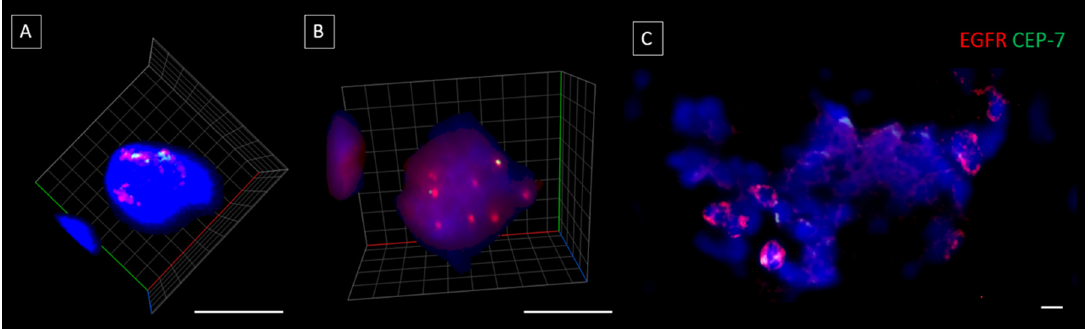
Figure 5. ( A , B ) 3D EGFR DNA FISH of single CTCs showing the number of EGFR signals (red) to CEP-7 (green). ( C ) EGFR DNA FISH of a CTC cluster showing a number of EGFR amplified cells. The ratio of EGFR:CEP-7 shows EGFR amplification in the CTCs. Scale bar represented 10 µ